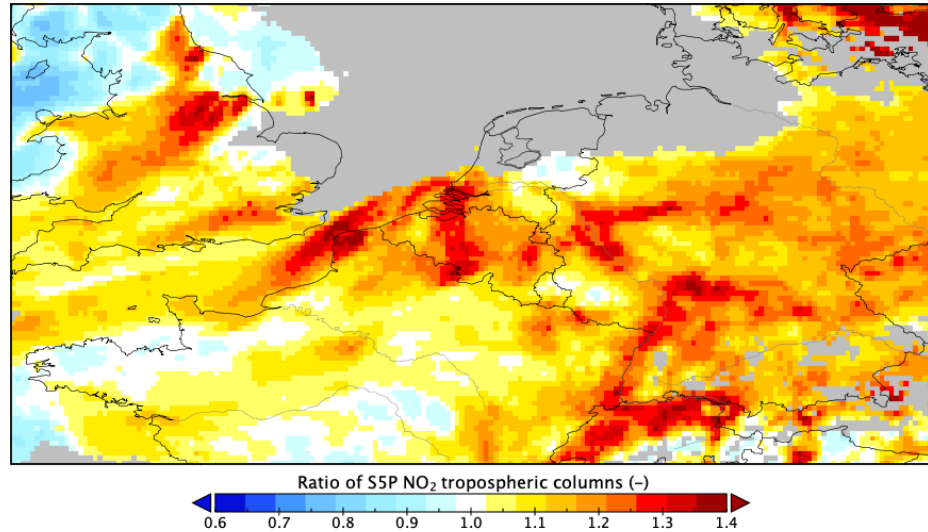
Figure 2. Ratio of TROPOMI tropospheric NO 2 columns when using the CAMS regional a priori NO 2 profiles with respect to TM5-MP a priori profiles over Belgium and neighbouring countries on 27 June 2019 (orbit